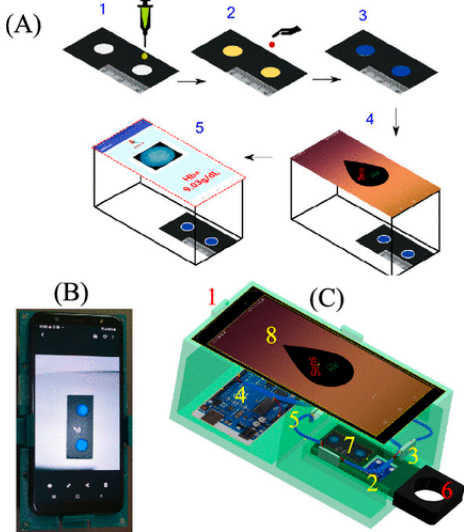
Figure 1. ( A ) Schematic representation of the detection protocol shown stepwise. Five key steps include (1) embedding chemical reagents on the paper device, (2) putting a drop of blood from finger prick, (3) colorimetric changes on the paper device, (4) placement of the device on a cartridge within a customized portable plastic box, and (5) smartphone integration, analytics, and dissemination based on colorimetric signals of the test outcome. For improved performance, prior to step (2), finger-pricked blood is mixed with Drabkin’s solution for 15 s before introducing onto the reaction spots. ( B ) Top-view image of the POC device during the testing of a blood sample. The smartphone app displays two reaction spots of the paper device. A greenish-blue color is developed after the reaction, which is captured by a smartphone. ( C ) Schematic representation of the present device is shown where the smartphone is placed on top of the 3D box. Key components are (1) sliding bars to fit in different models of smartphone, (2) light intensity-measuring microchip that continuously sends feedback to maintain uniform light intensity, (3) LED light source, (4) Arduino board, (5) cable connections between the Arduino board with a light measurement unit and (6) paper-made cartridge, (7) paper-based reaction spots, and (8) smartphone with the Sens-Hb app. Reprinted with permission from [18]. Copyright 2021 American Chemical